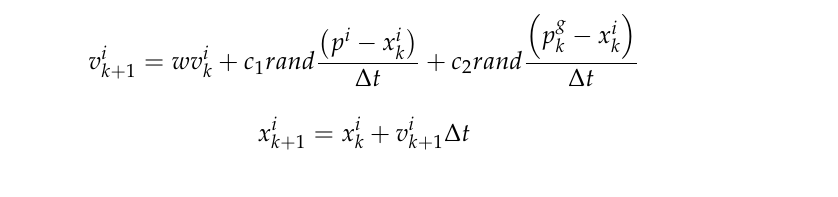
Figure 12. Main program flow chart for HEV OOP model (for series, parallel and SP).